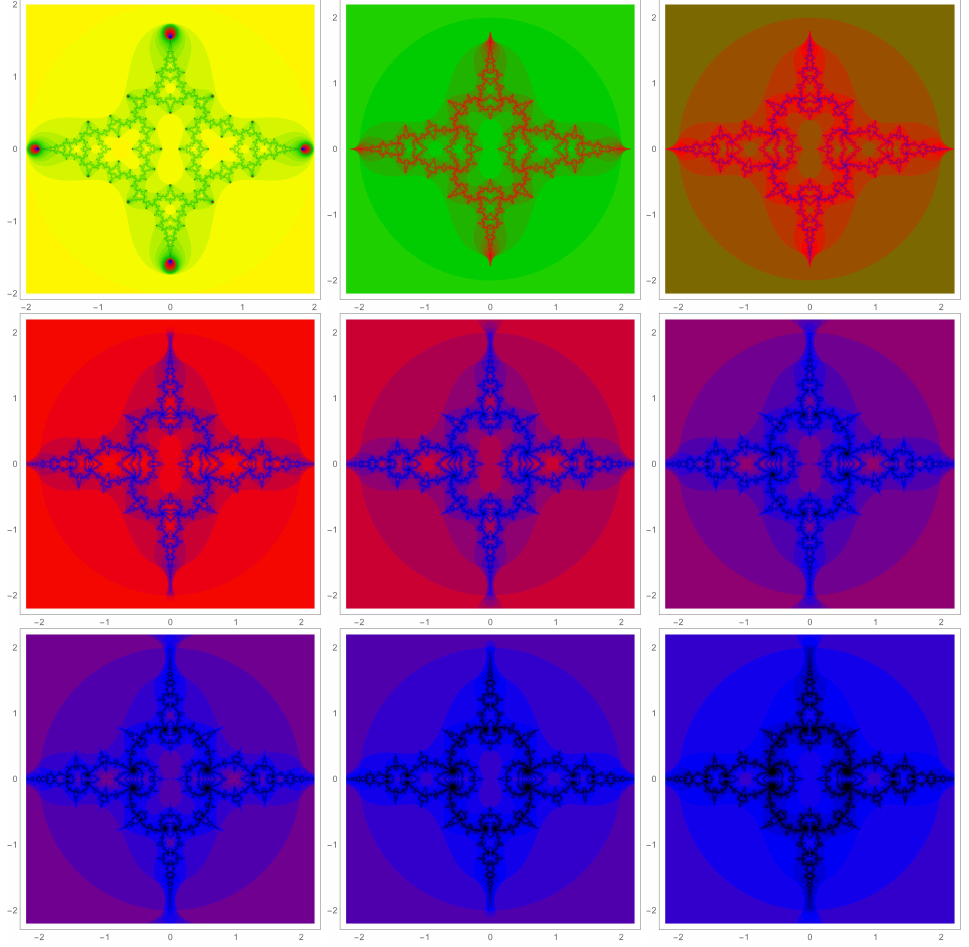
Figure 6. j -averaged filled-in Julia sets from points in the j -averaged Mandelbrot sets at positions of the orange data points in Figure 4. Domains 1 through 9 are shown. The appearance has significant similarities. One important difference is that the number of strands crossing from one side of an arm to the other is equal to the domain